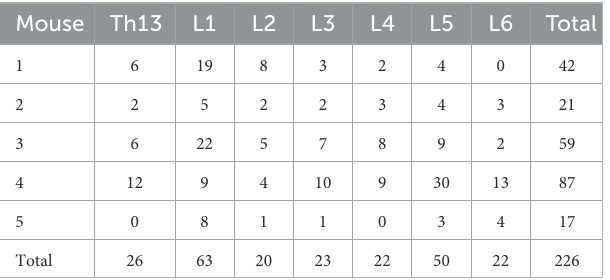
TABLE 1 Number of FG + neurons in